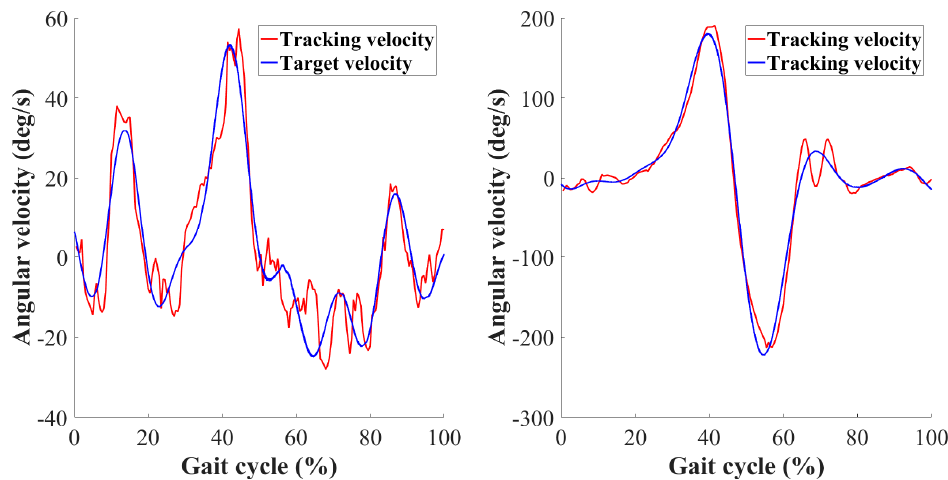
Figure 8. Gait angular velocity tracking results of the hip ( left ) and knee ( right ) joint after 10 iterations.